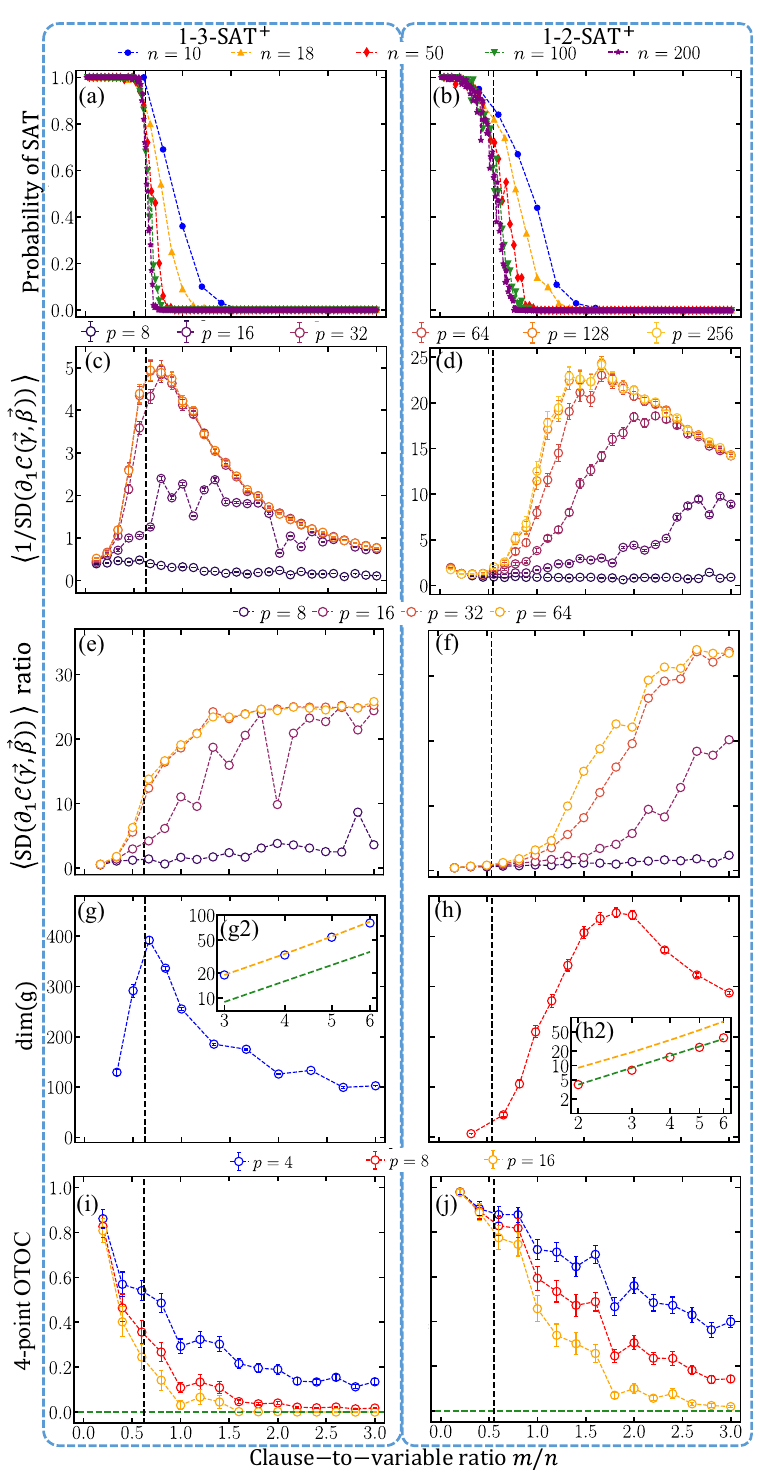
Fig. 2 SAT-UNSAT phase transition and trainability of 1-3-SAT + (left column) and 1-2-SAT + . a , b Probability of SAT for different system size ! n . c , d The mean of 1 = SD ð ∂ 1 Cð γ ! ; β ÞÞ in different p -layer QAOA with n = 18 variables. The inverse is added for easier comparison according to ! Eq. (4). e , f The ratio between the average gradient variance h SD ð ∂ 1 Cð γ ! ; β ÞÞi of n = 6 variables over that of n = 18 variables in different p -layer QAOA. Larger ratio indicates barren plateau. g , h The dimension of dynamical Lie algebra dim ð g Þ for generators in QAOA in an n = 6 qubits system (see Eq. 4). The inset log-log plots (g2) and (h2) show dim ð g Þ versus n with a fully symmetric H C . Green and orange curves represent the lower bound estimate dim ð g Þ ¼ n 2 and upper bound of dim UB . i , j Average of 4-point OTOC for different p -layer QAOA with n = 10 variables (see Eq. 5). Green horizontal dashed line represents the value given by Haar unitary − 2 n /(4 n − 1). Vertical dashed lines indicate the critical SAT-UNSAT transition point. All results and error bars are estimated over 100